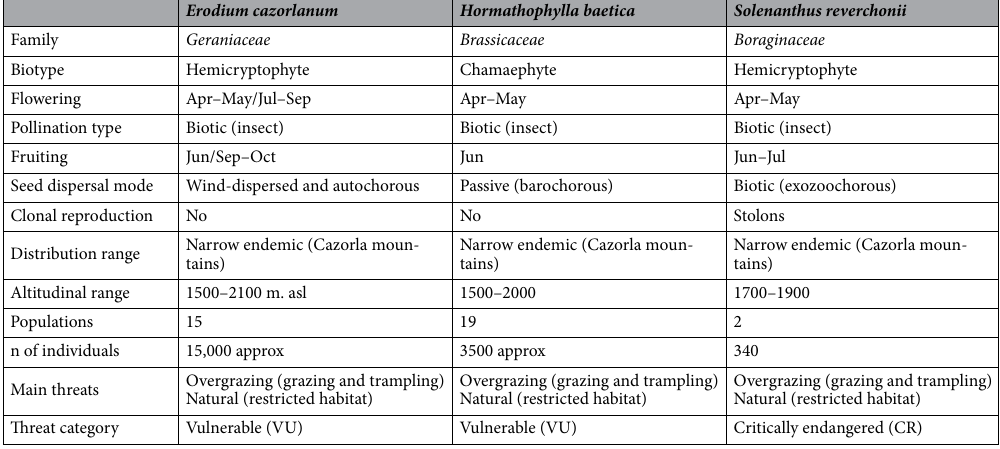
Table 1. Main features of the studied species 18,20,38,44